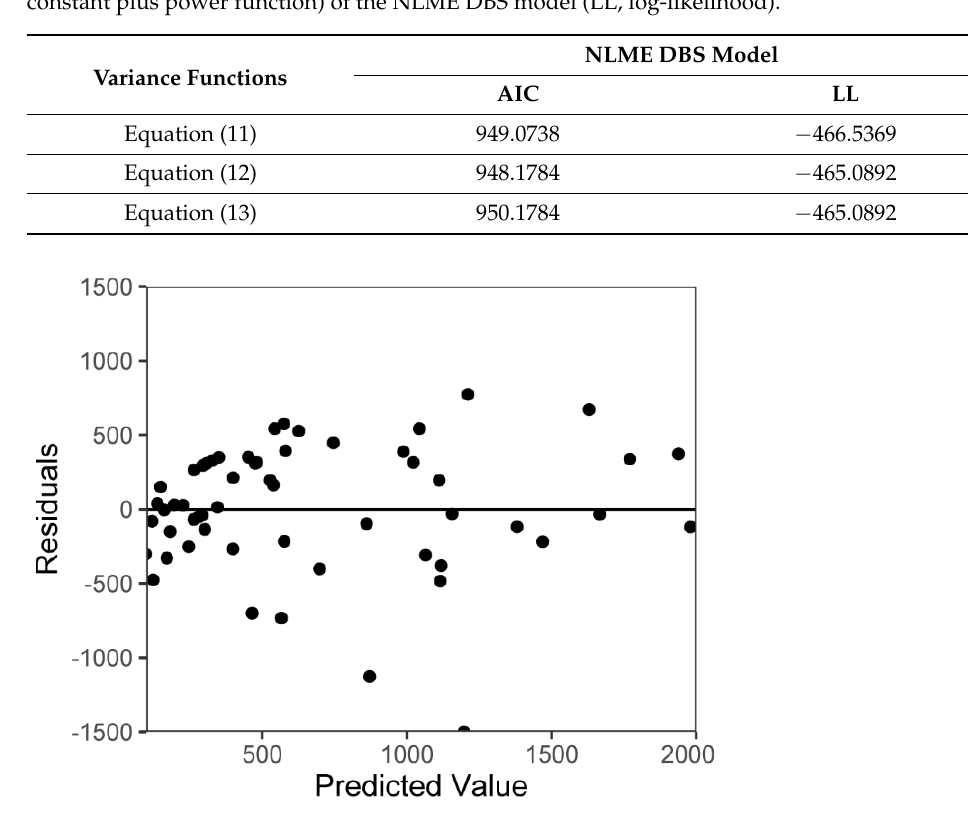
Figure 6. Residual distribution of Model (21).